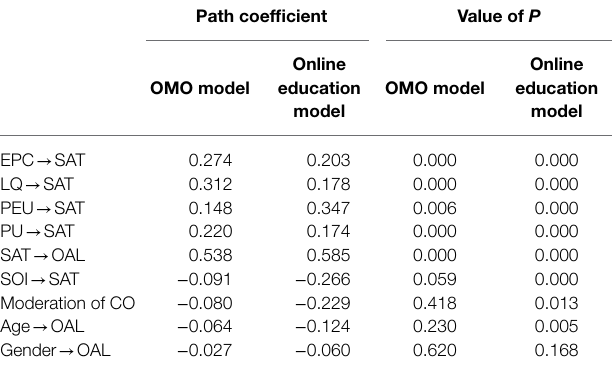
TABLE 6 | PLS-MGA results.